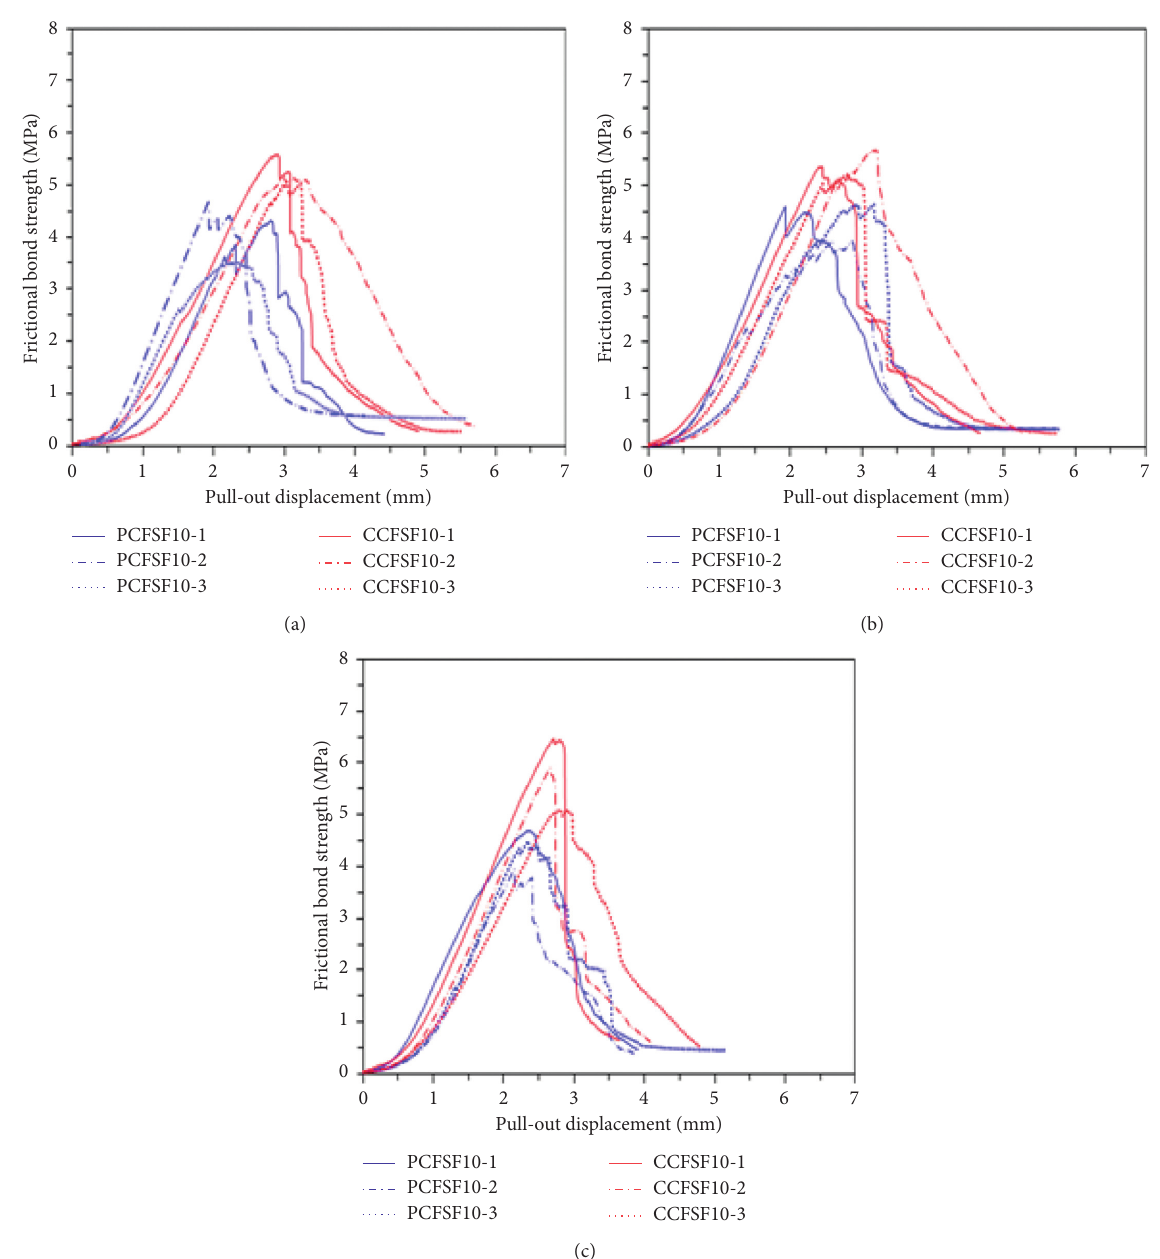
Figure 12: Stress-displacement curves of the pull-out test for the specimens with 10 wt.% SF. (a) 3 d. (b) 7 d. (c)